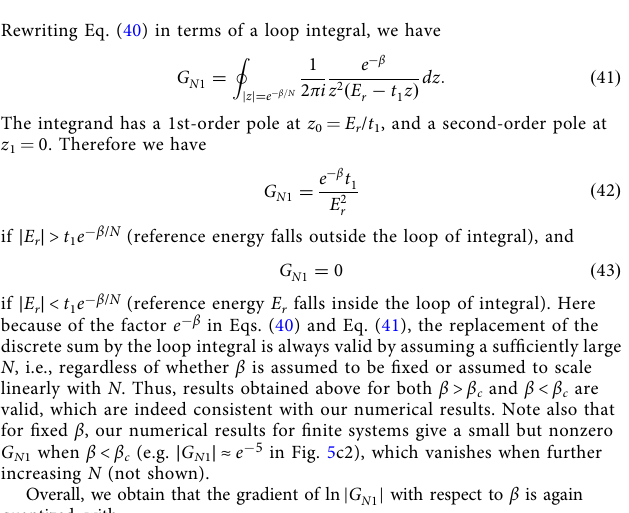
Fig. 5 The Hatano-Nelson model with only the nearest-neighbor hoppings. a Spectra under periodic (cyan loop) and open (gray dots) conditions (PBC and OBC), and that within the PBC-OBC interpolation through a modi fi cation factor e − β of the couplings across the boundary (black circles). The red star indicates the reference energy E r = ω + i γ for further results in ( b ) and ( c ). Here E r falls right on the spectrum of the Hamiltonian H β , and the value of β = β c ≈ 6.2 is read out from ( b ) and ( c ). b and c show the ampli fi cation ratios given by the off-diagonal elements of the Green ’ s function ∣ G [( b2 ) and ( c2 )] and the derivatives of their logarithms over β [( b3 ) and ( c3 )] as functions of β , where the quantity I β ( E r ) indicates with its peaks when E r is passed through by the H β spectrum. The parameters are t 1 = 1 and t − 1 =